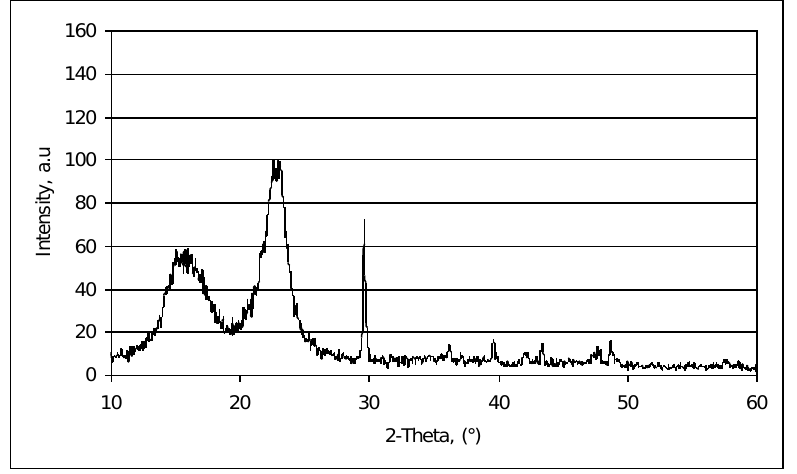
Figure 7. X-ray diffraction patterns of paper samples obtained by in-situ loading method.